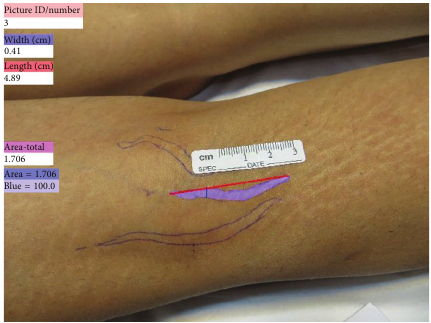
Figure 2: Striae alba on the right calve one month after the end of study. The purple areas denote the measured area by PictZar Digital Planimetry